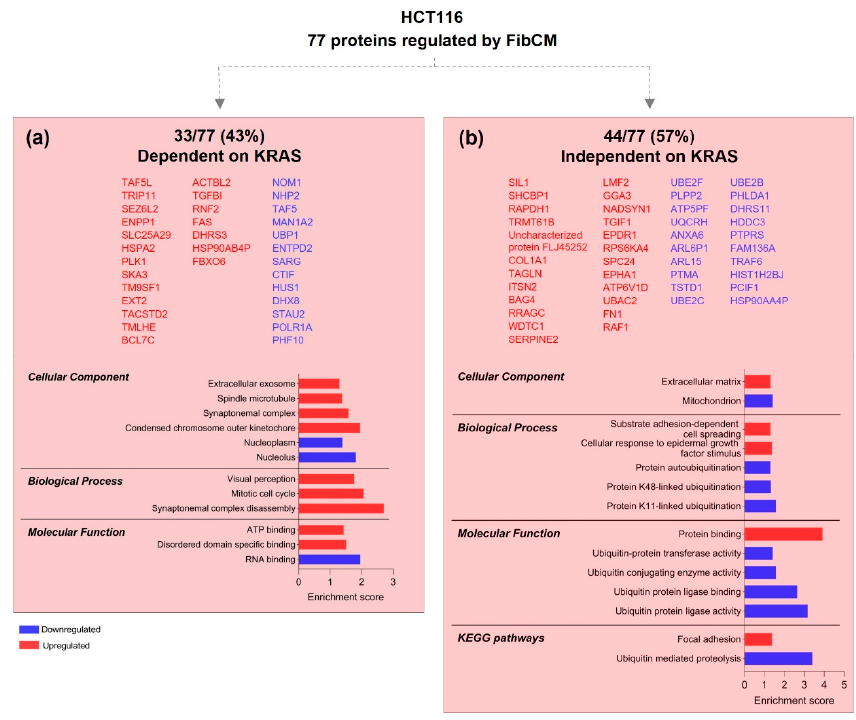
Figure 2. KRAS-dependent and independent differentially expressed proteins in HCT116 cells. GO and KEGG pathways analysis of KRAS-dependent proteins, i.e., commonly found but differ- entially expressed upon siKRAS ( a ), and KRAS-independent proteins, i.e., proteins exclusively found as an effect of the FibCM in siCTRL cells (siCTRL_FibCM vs. siCTRL_ctrlCM) ( b ). Protein lists are organized according to the abundance ratio. The enrichment score was calculated by—log p -value. LS174T cells differentially expressed 69 proteins in response to fibroblast-secreted factors (Figure 1c). From these, 26 (38%) were KRAS-dependent—also found in siKRAS cells cultured with FibCM, though differentially expressed; and 43 (62%) were inde- pendent of KRAS—only identified in siCTRL cells treated with FibCM (Figure 3a,b and Supplementary File S10).